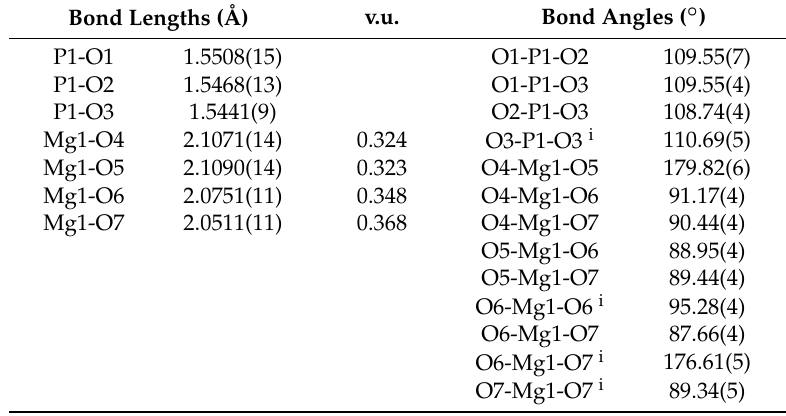
Table 2. Bond lengths, selected bond valences and bond angles for struvite.